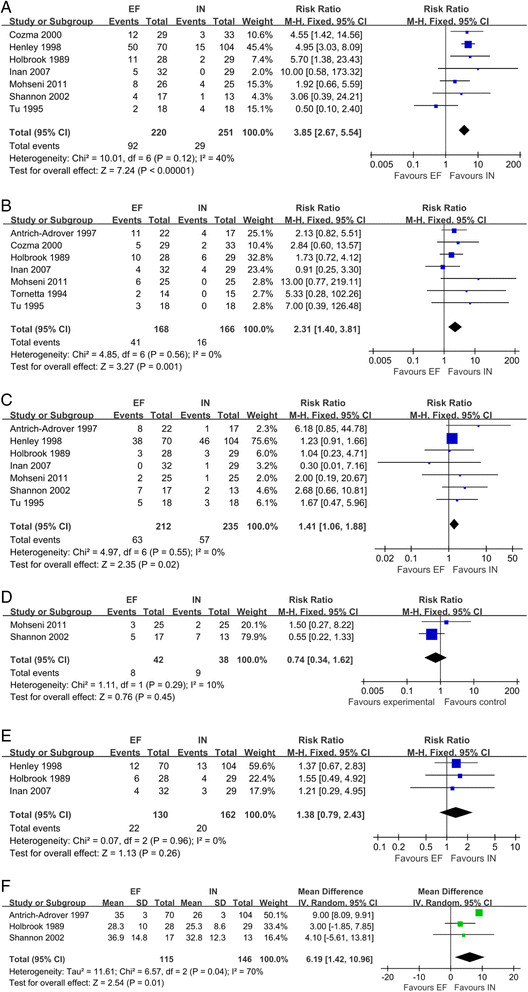
Forest plots for comparing the clinical outcomes between intramedullary nails and external fixation. (A) Postoperative infection. (B) Malunion. (C) Nonunion. (D) Soft tissue injury. (E) Delayed healing. (F) healing time.